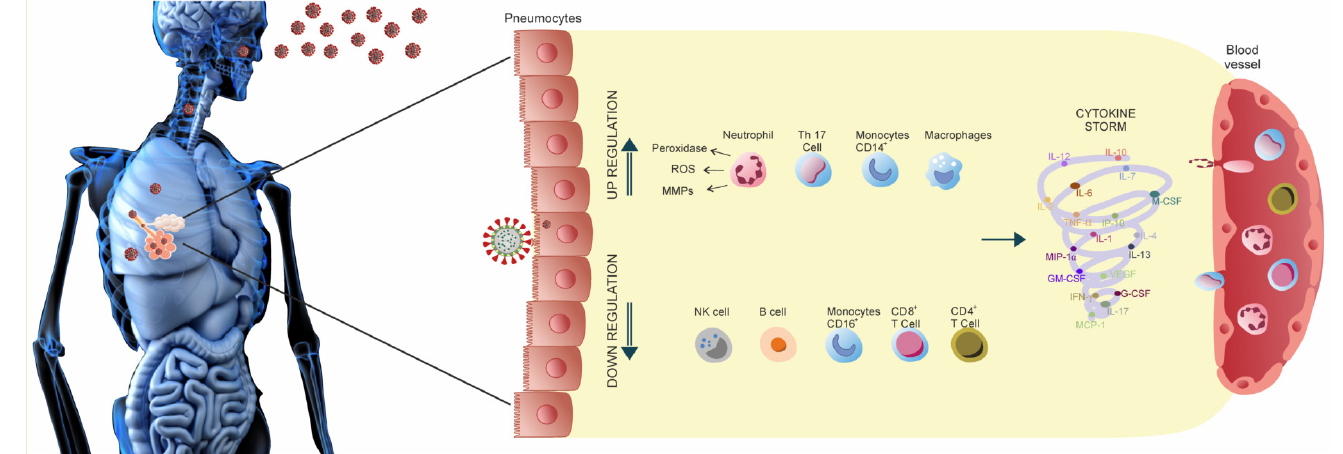
Figure 1. Cytokine storm in COVID-19.